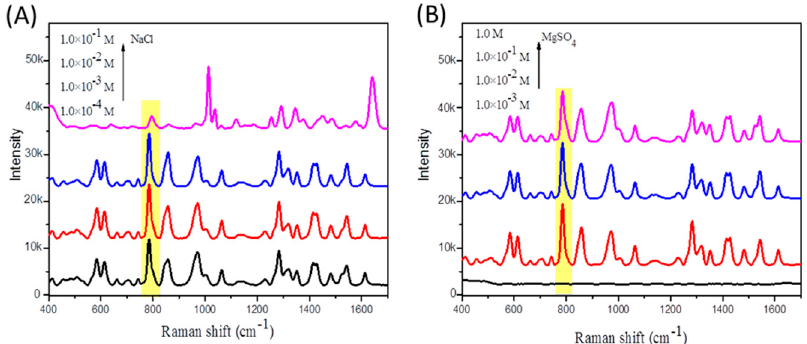
Figure 6. ( A ): SERS spectra of flumetsulam absorbed on the two-step modified concentrated AuNPs substrate with NaCl at different concentrations (1.0 × 10 − 4 to 1.0 × 10 − 1 mol/L). ( B ): SERS spectra of flumetsulam absorbed on the two-step modified concentrated AuNPs substrate with MgSO 4 at different concentrations (1.0 × 10 − 3 to 1.0 mol/L).